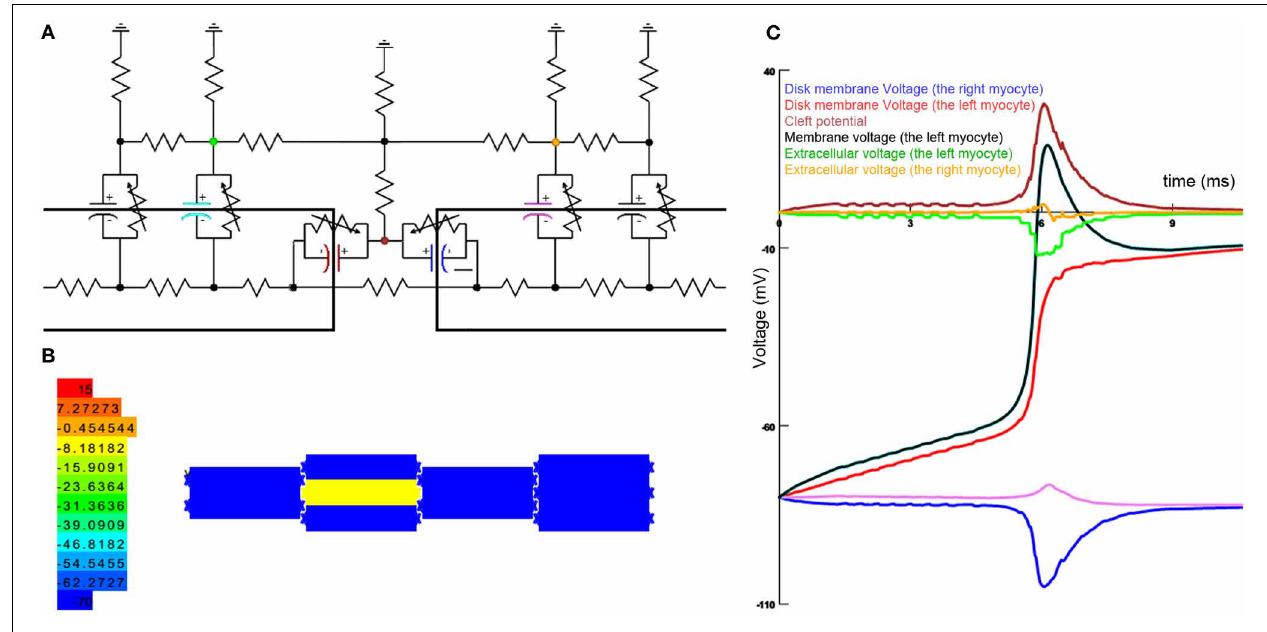
FIGURE 1 | Capacitive coupling simulation. (A) The equivalent circuit of intercalated disk. (B) Cell arrangement in the final model. Colors show the membrane potential in all cells. (C)